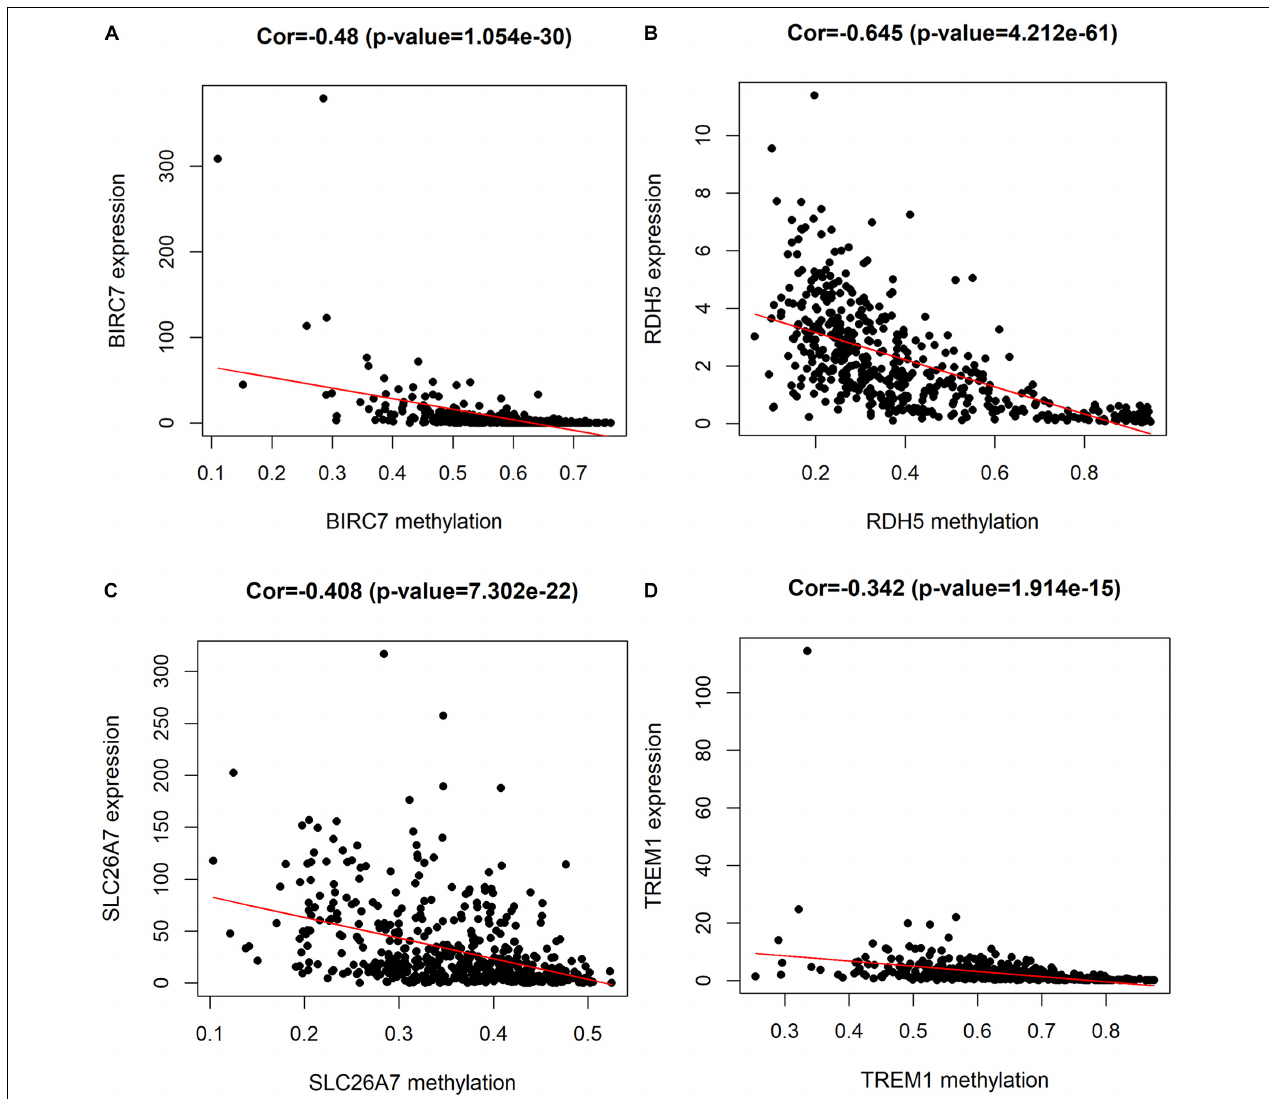
FIGURE 5 | Correlation between the expression and methylation degree of BIRC7 (A) , RDH5 (B) , SLC26A7 (C) , and TREM1 (D) in the risk model. X -axis represents the methylation degree and Y -axis represents gene expression level.